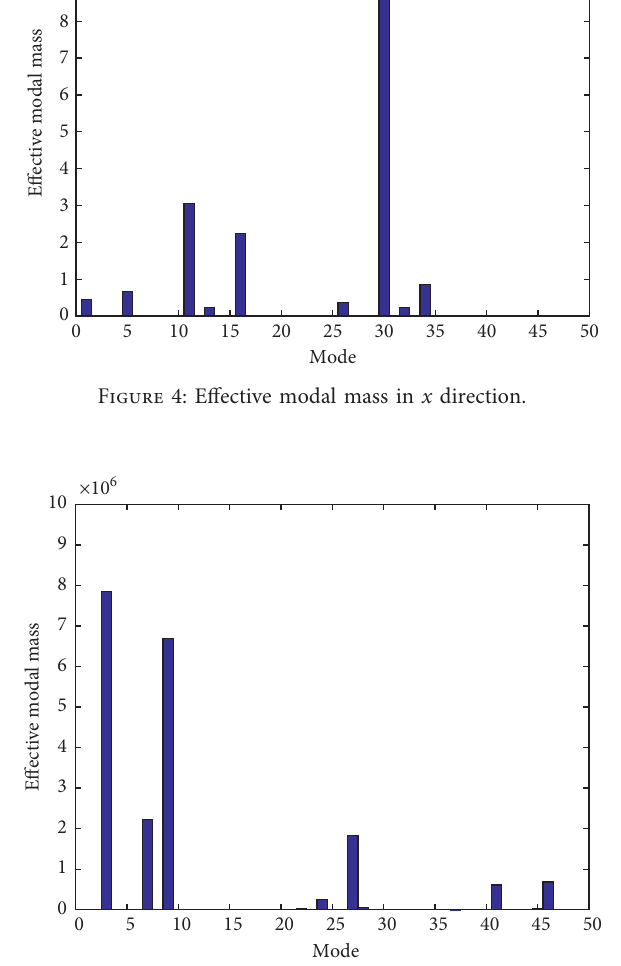
Figure 5: Effective modal mass in y